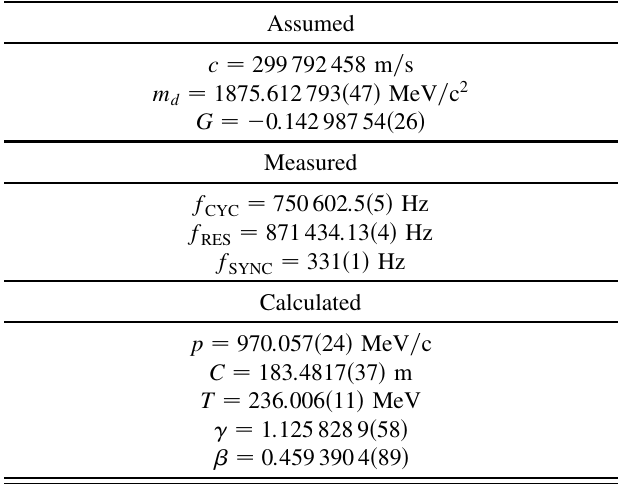
TABLE IV. Beam and machine